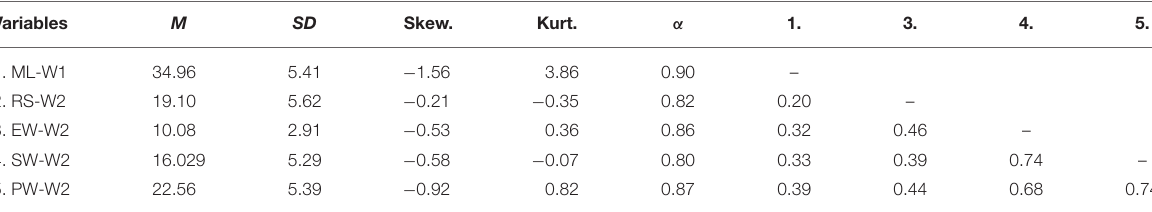
TABLE 1 | Descriptive statistics and correlations for study variables.